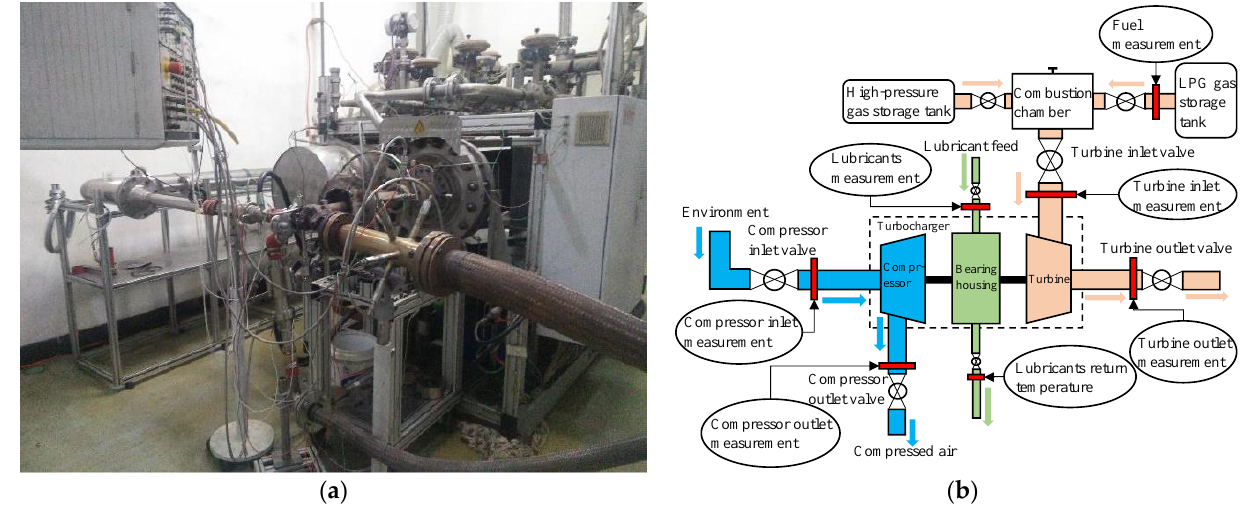
Figure 6. ( a ) Kratzer test bench; ( b ) schematic diagram of the test bench arrangement.